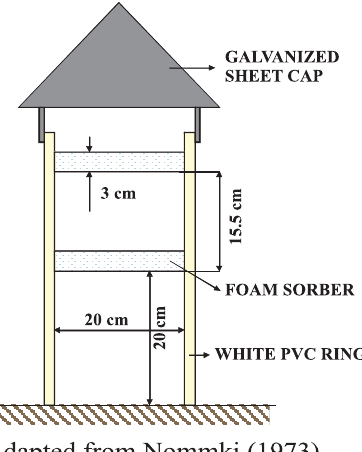
Figure 2. Semi-open static collection chamber for determination of N-NH